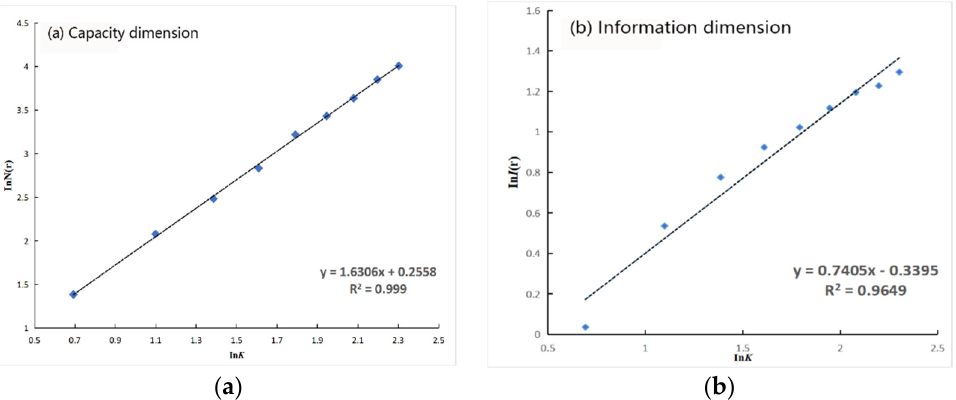
Figure 2. Double logarithmic scatter plots of the grid dimension of rural tourism resources in Guangdong; ( a ) Capacity dimension, ( b ) Information dimension.